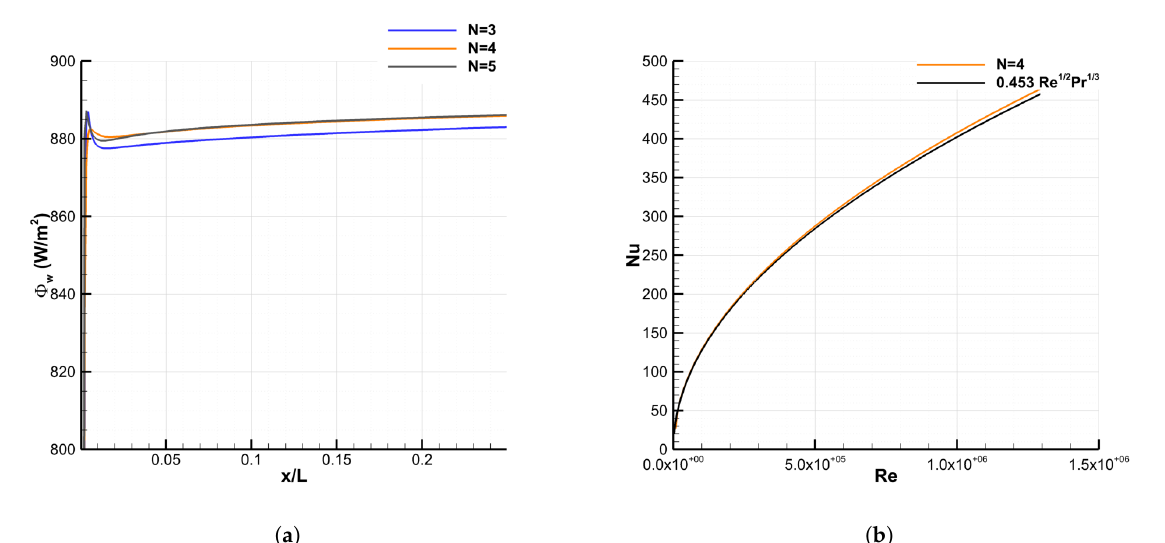
Figure A1. Validation of ( a ) the wall heat flux and ( b ) the Nusselt number. Test case 3, with wall temperature varying as x 1/2 , m = 0. N = 3 to N = 5, N x =